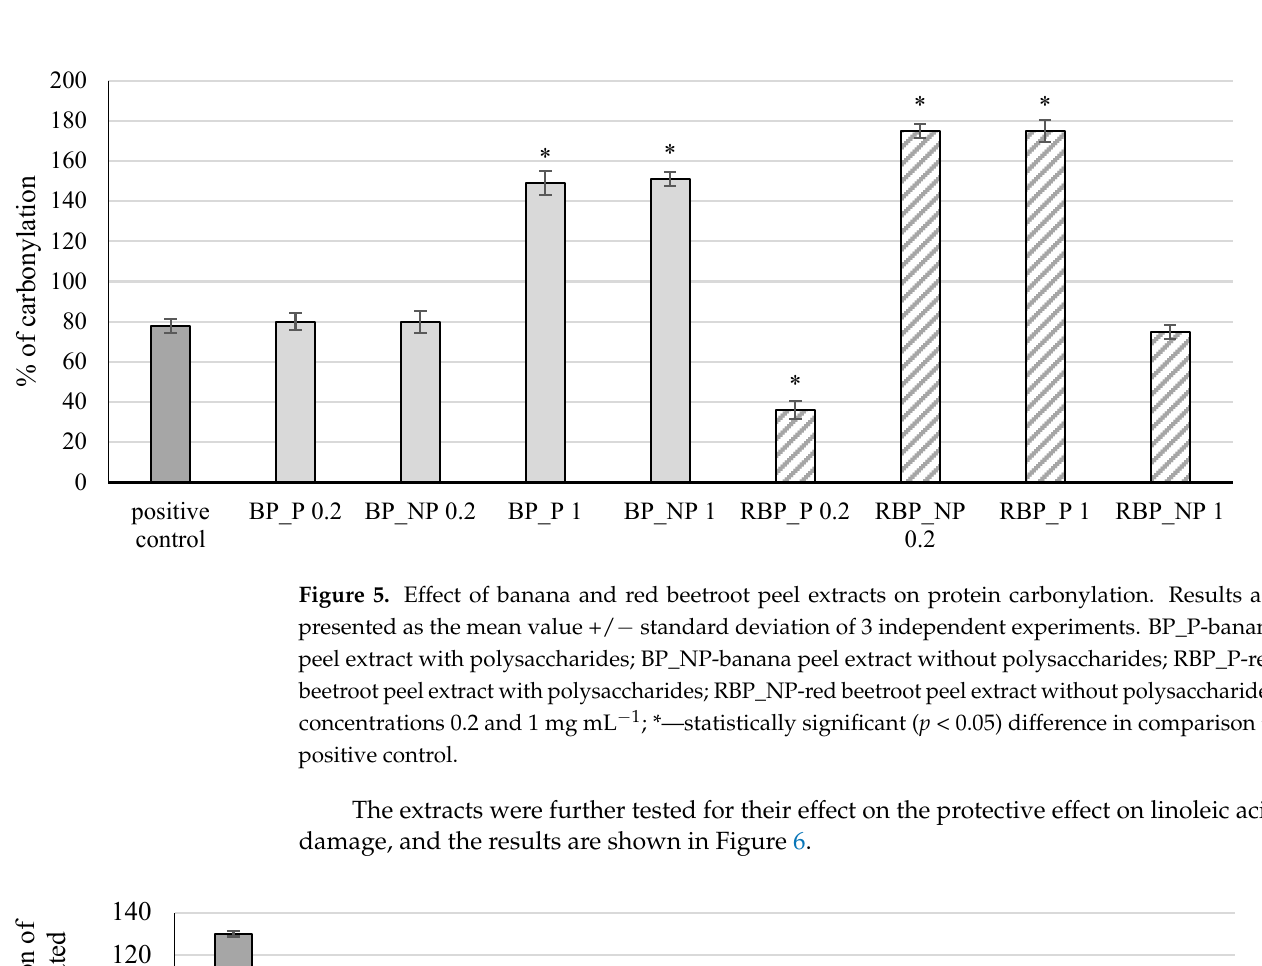
Figure 5. Effect of banana and red beetroot peel extracts on protein carbonylation. Results are pre ‐ sented as the mean value +/ − standard deviation of 3 independent experiments. BP_P ‐ banana peel extract with polysaccharides; BP_NP ‐ banana peel extract without polysaccharides; RBP_P ‐ red beet ‐ root peel extract with polysaccharides; RBP_NP ‐ red beetroot peel extract without polysaccharides, concentrations 0.2 and 1 mg mL ‐ 1 ; *—statistically significant ( p < 0.05) difference in comparison to